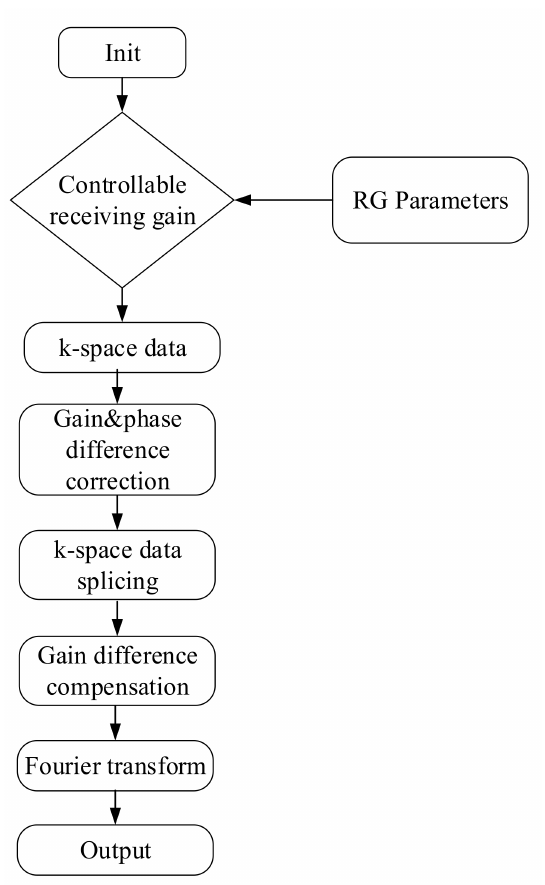
Figure 1. System execution